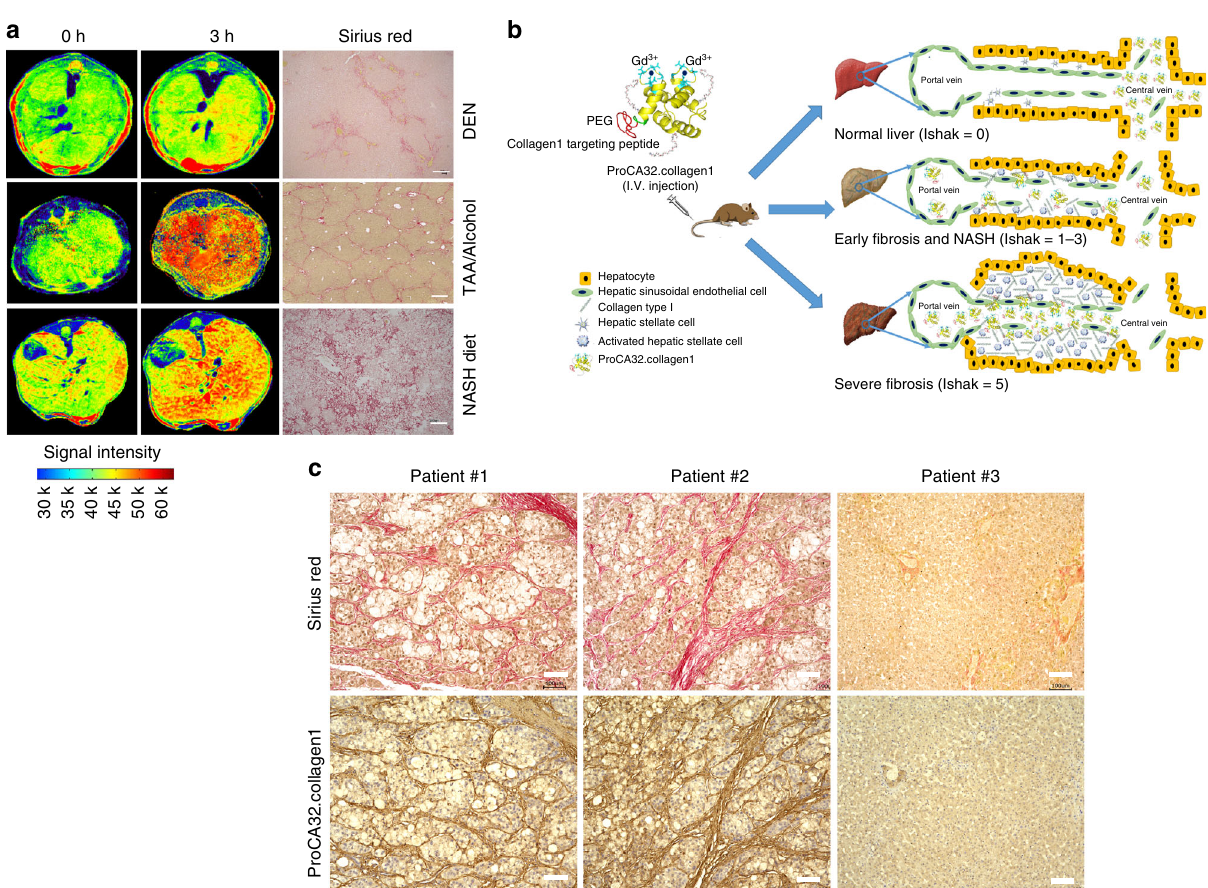
Fig. 7 Human translational potential of ProCA32.collagen1. a ProCA32.collagen1 enhanced MRI can demonstrate different collagen distribution in DEN-, NASH diet-, and TAA/alcohol-induced models. b Schematic illustration of ProCA32.collagen1 distribution and suggested mechanism in different stages of fi brosis. c Demonstration of three hepatocellular carcinoma (HCC) and normal human liver tissue microarray stained with Sirius red (red) and ProCA32. collagen1 (brown) exhibiting the strong binding of the contrast agent to collagen human patient tissue (all scale bars, 100 µ